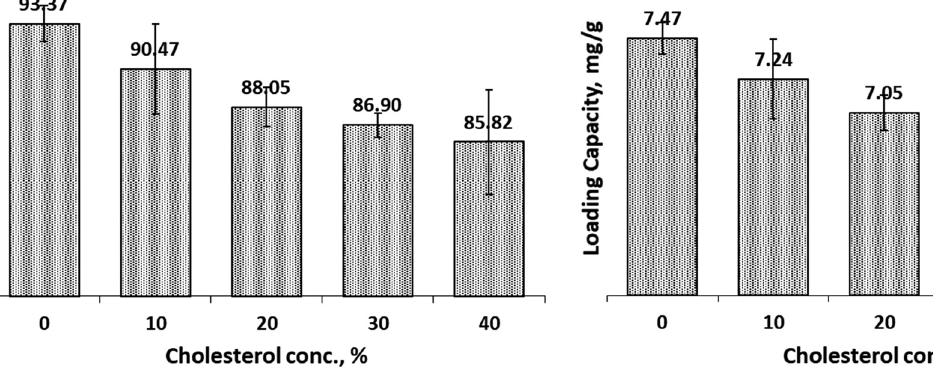
Figure 5: Encapsulation e ffi ciency of Cur in cocoliposome in SIF solution as a function of cholesterol.